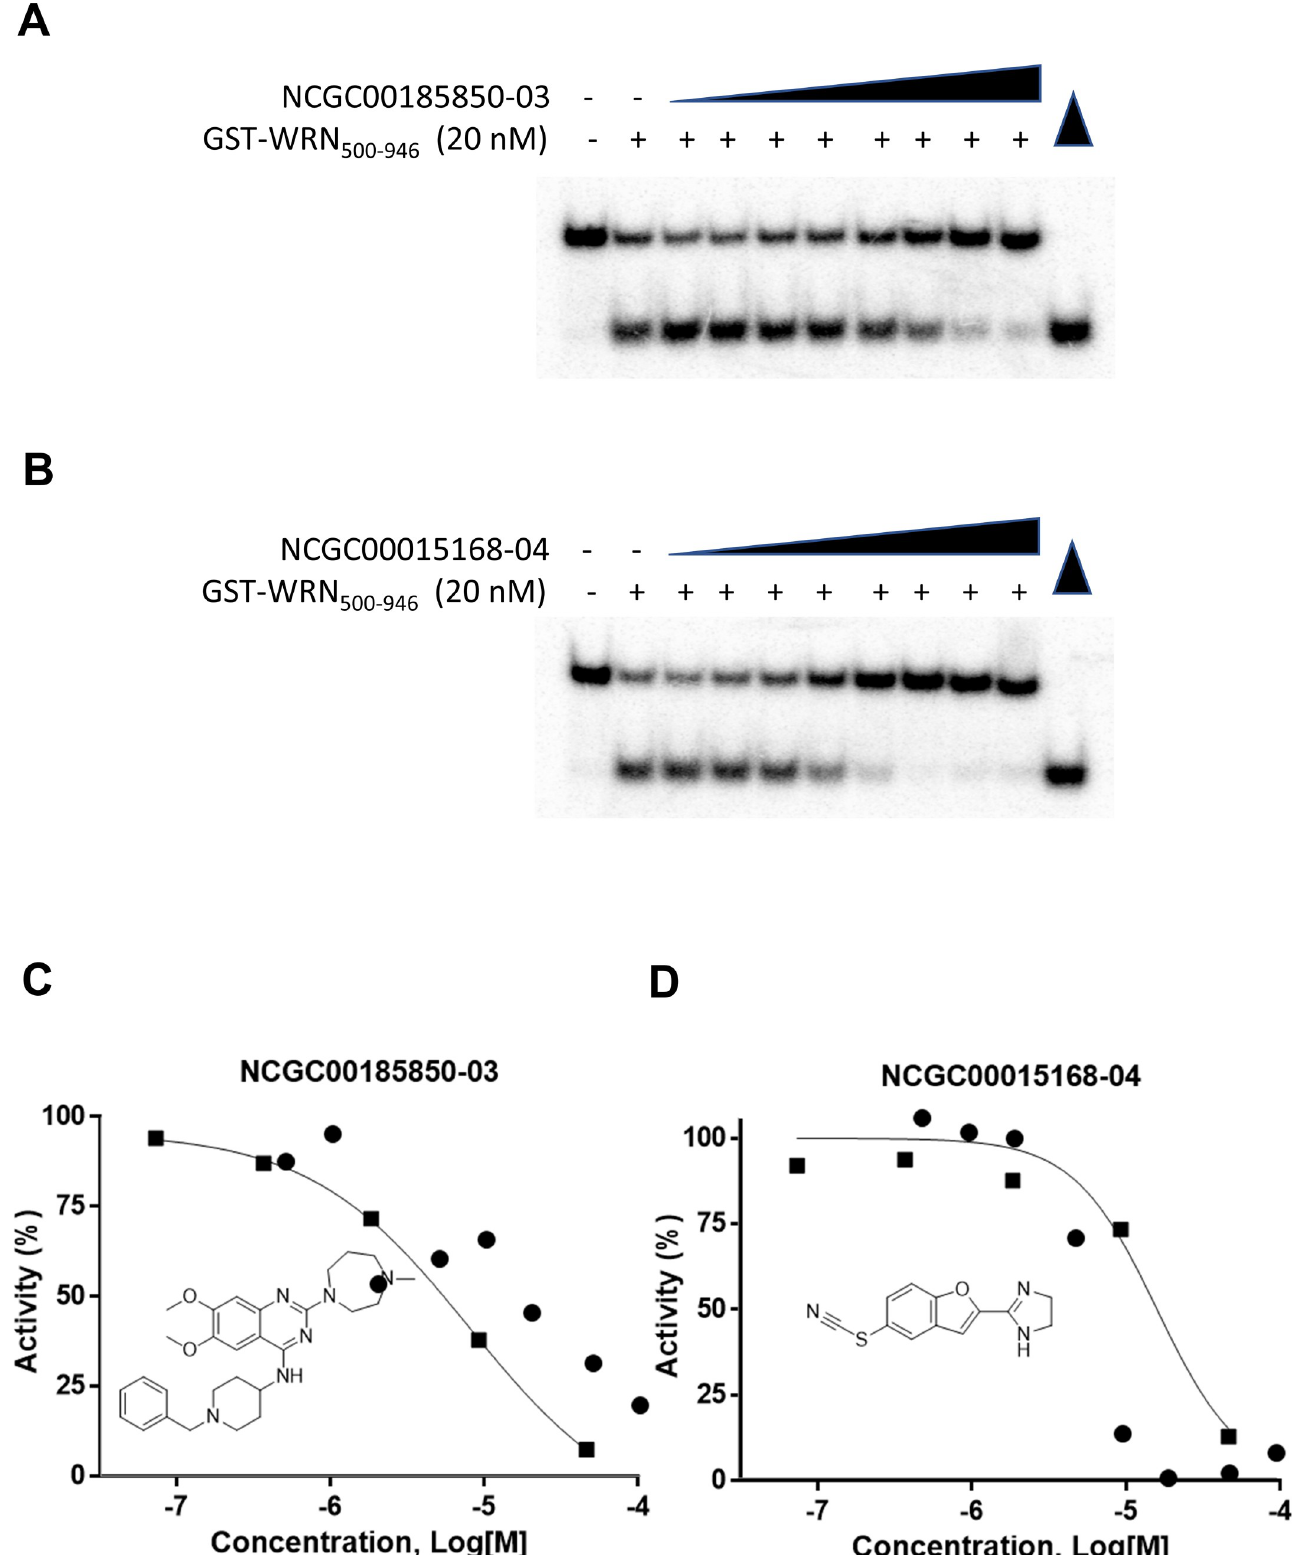
Fig 4. Comparison of Radiometric and high-throughput fluorescent helicase assays. (A) Gel image showing inhibition of GST-WRN 500-946 (20 nM) unwinding of the radiolabeled FORKR DNA substrate (0.5 nM) by increasing concentrations of NCGC00185850-03. (B) Gel image showing inhibition of